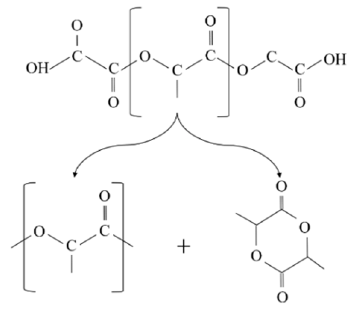
Figure 2. Schematic diagram of poly(lactic acid) (PLA) random chain scission during thermal degradation.